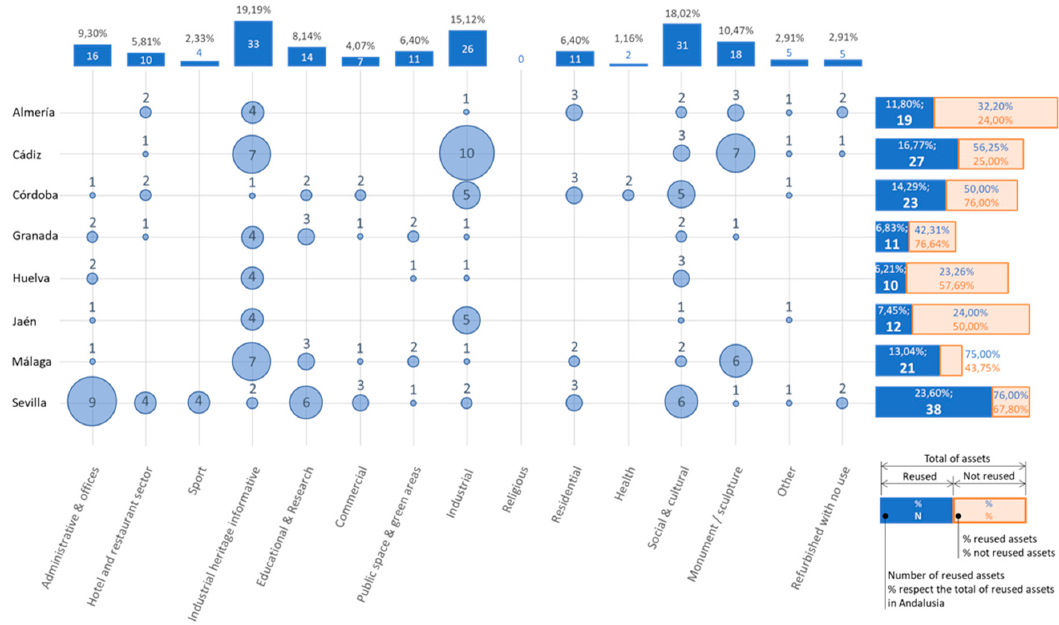
Figure 10. Distribution of assets simultaneously considering location and the new use when it exists.